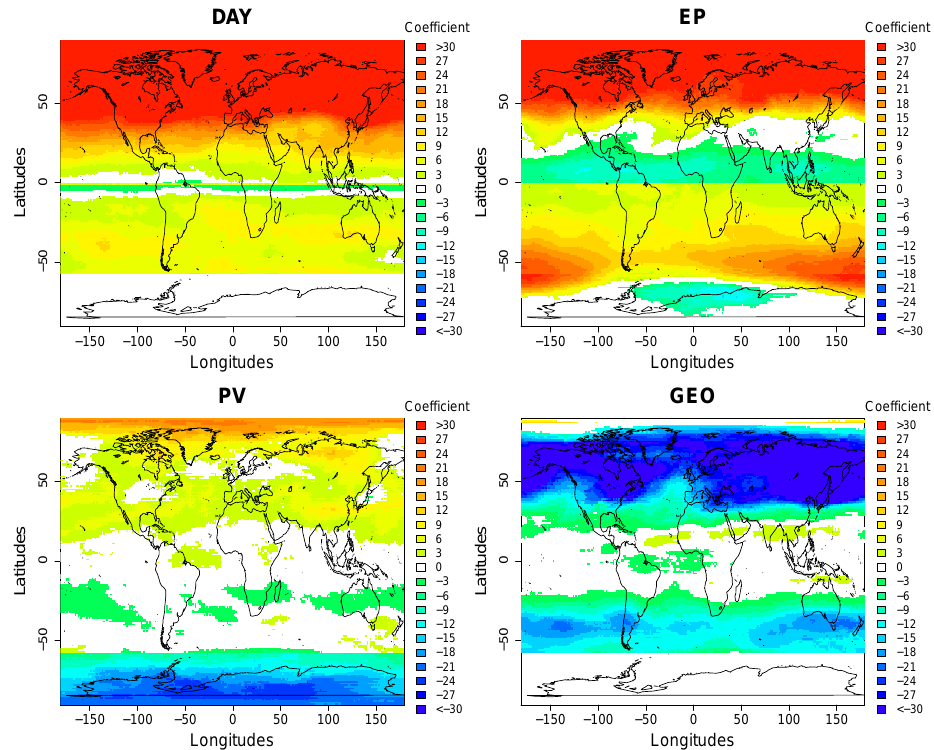
Figure 5. Regression coefficient estimates of seasonal variables for the PHYS model on a 1 × 1.5 ◦ grid. Note that, among the variables, in group B only EP and PV are included south of 55 ◦ S in latitude to avoid correlation problems. The coefficients are in DU per unit change of corresponding normalized explanatory variable. White regions indicate nonsignificant regression estimates at the 99% confidence